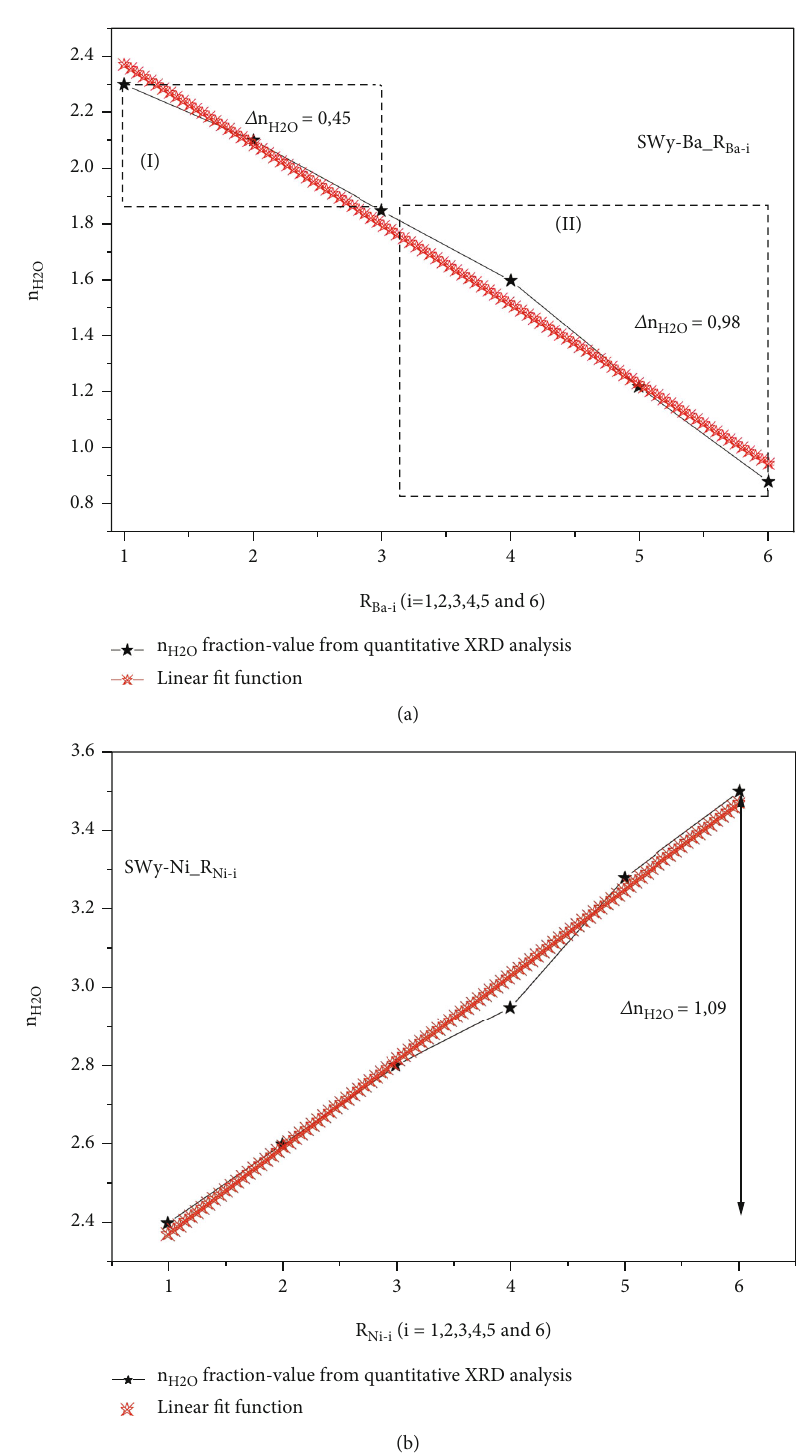
Figure 5: n abundance fl uctuation versus R H2O